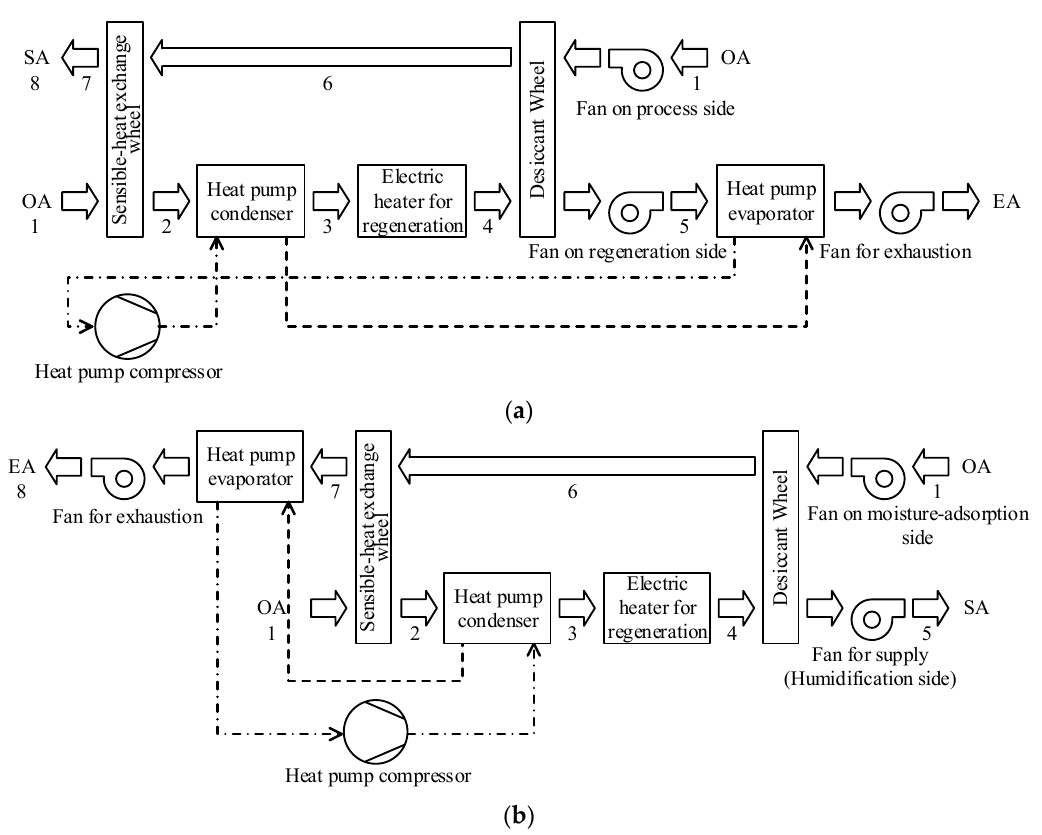
Figure 3. Operational flow of the experimental system for ( a ) summer dehumidification; and ( b ) winter humidification. SA = supply air; OA = outdoor air; EA = exhaust air.